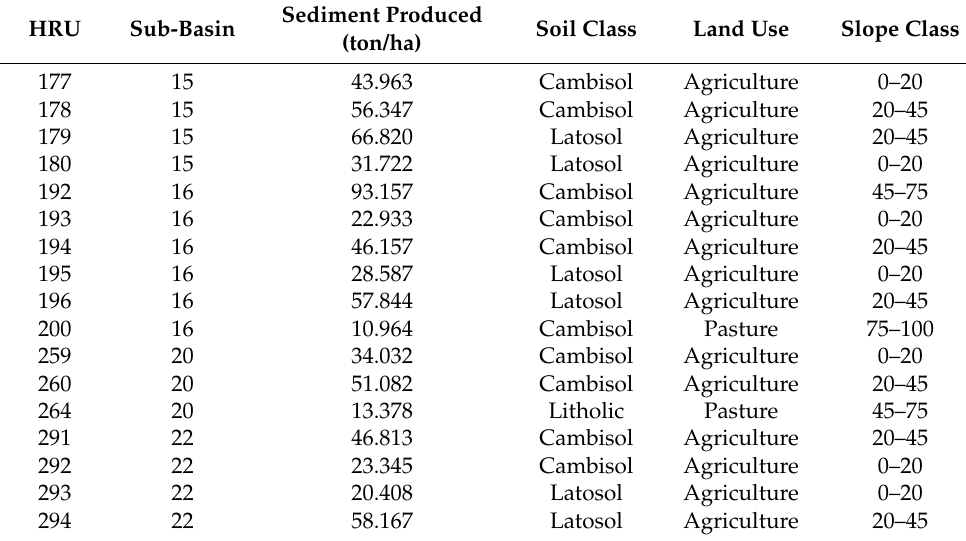
Table 6. Sediments produced at the